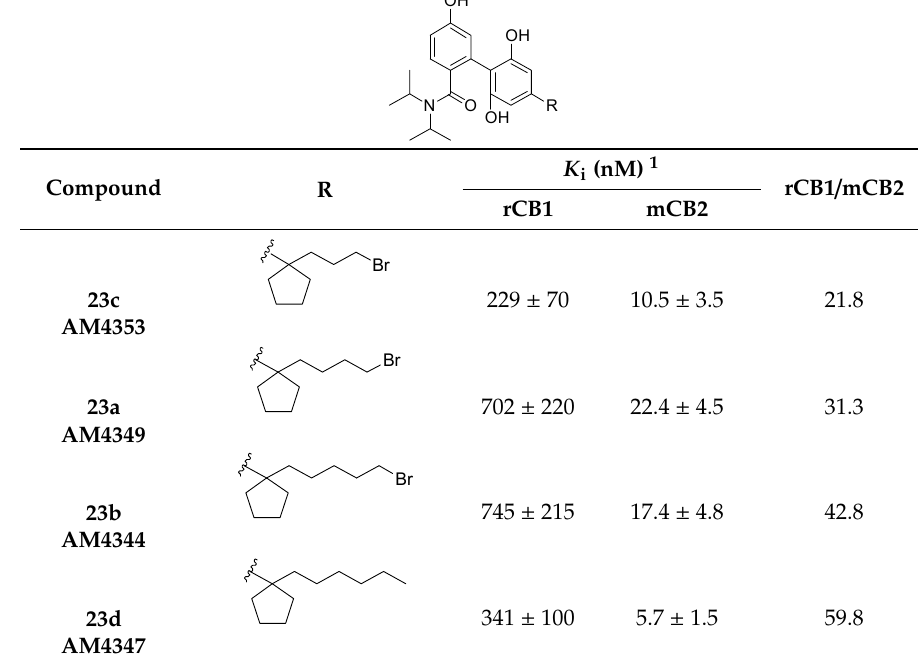
Table 3. Affinities of biphenyl analogs for rCB1 and mCB2 cannabinoid receptors (± 95% confidence limits).